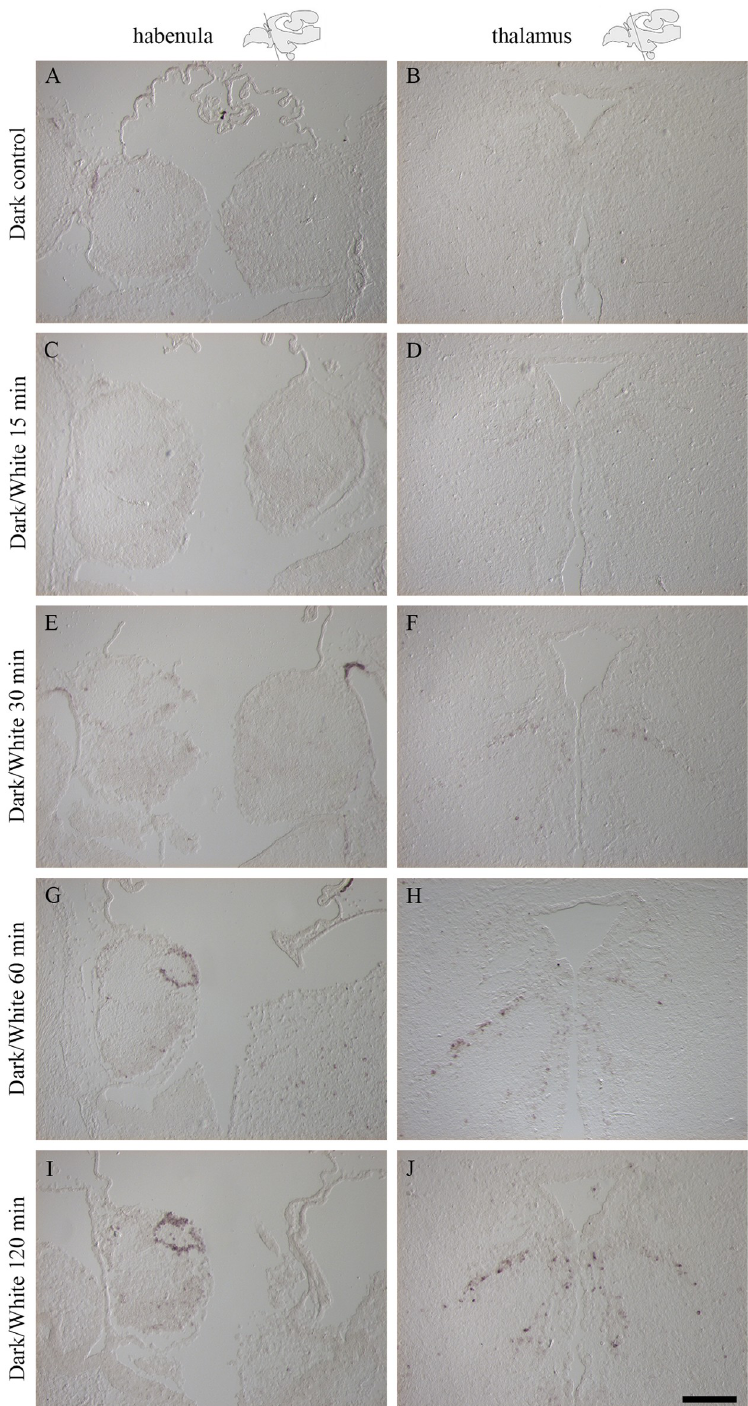
Fig 2. Activation of the immediate early gene c-fos after stimulation with white light was strongest after 120 minutes of light exposure. In situ hybridization with c-fos is shown in the habenula (A, C, E, G, I) and thalamus (B, D, F, H, J) and schematic drawings indicate the plane of the cryo-section. A-B: Dark control, no c-fos expression detected. C-D: Sampling after 15 minutes exposure to white light, no c-fos expression detected. E-F: Sampling after 30 minutes exposure, weak c-fos expression detected. G-H: Sampling after 60 minutes exposure, strong c-fos expression detected. I-J: Sampling after 120 minutes exposure, the strongest c-fos expression detected. Scale bar of 200 μ m.